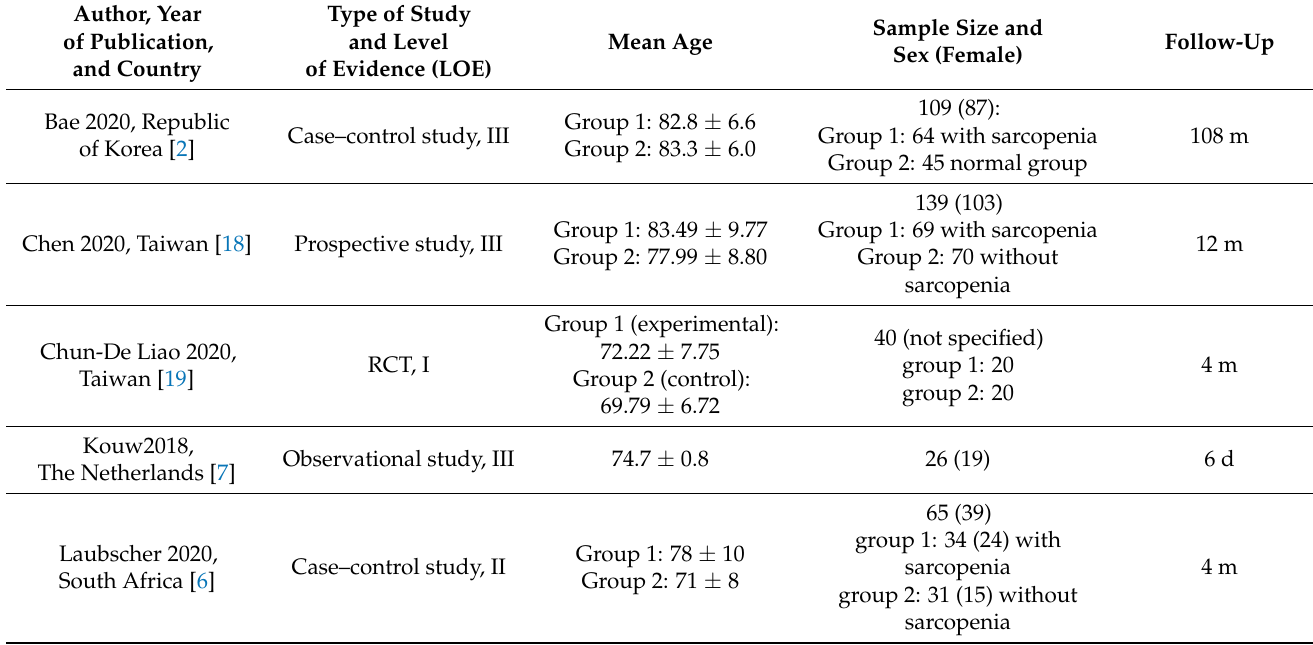
Table 1. Characteristics of the included